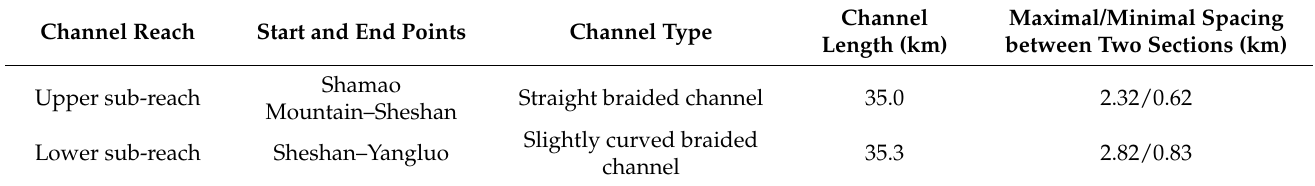
Table 1. Essential information of the two sub-reaches in the Wuhan reach.